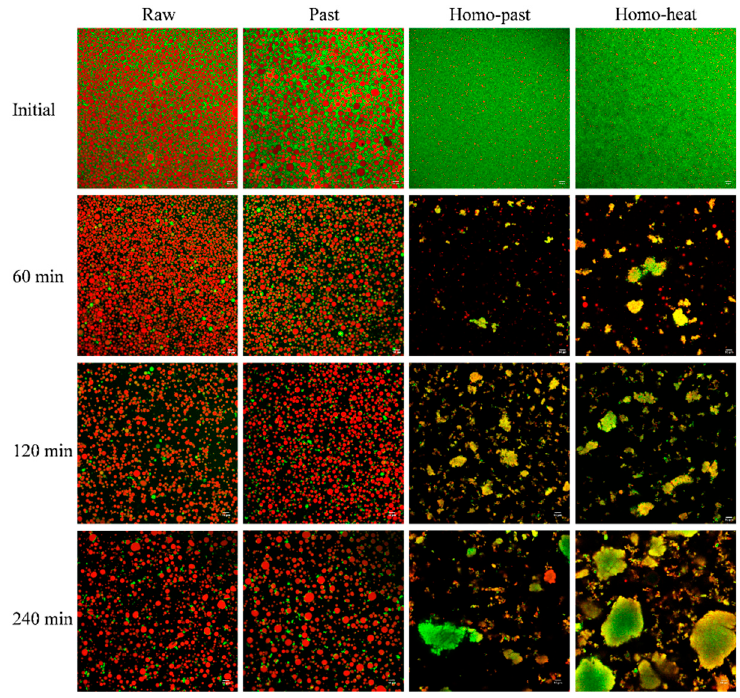
Figure 9. Confocal micrographs of digesta obtained at different time points (0–240 min) during in vitro gastric digestion of raw, pasteurized (Past), homogenized and pasteurized (Homo–past), and homogenized and heated (Homo–heat) sheep milks. Red shows the fat and green shows the protein. The scale bar in all images is 10 µ